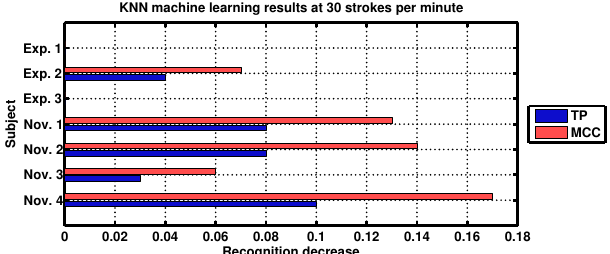
Figure 7: Machine learning results for the KNN classifier at 30 strokes per